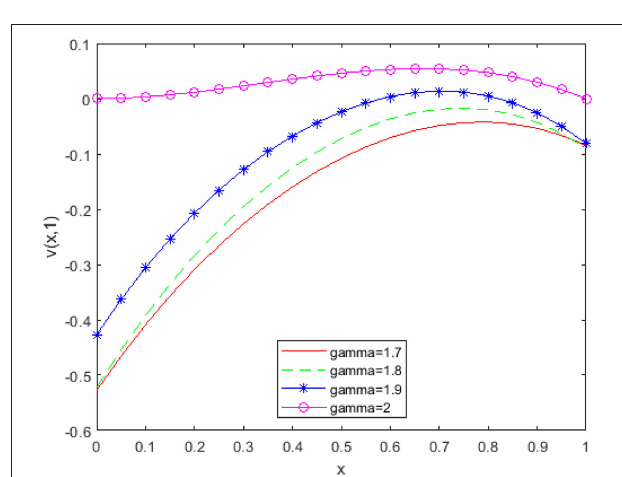
FIGURE 7 | Absolute errors at n = 5 and γ = 2.